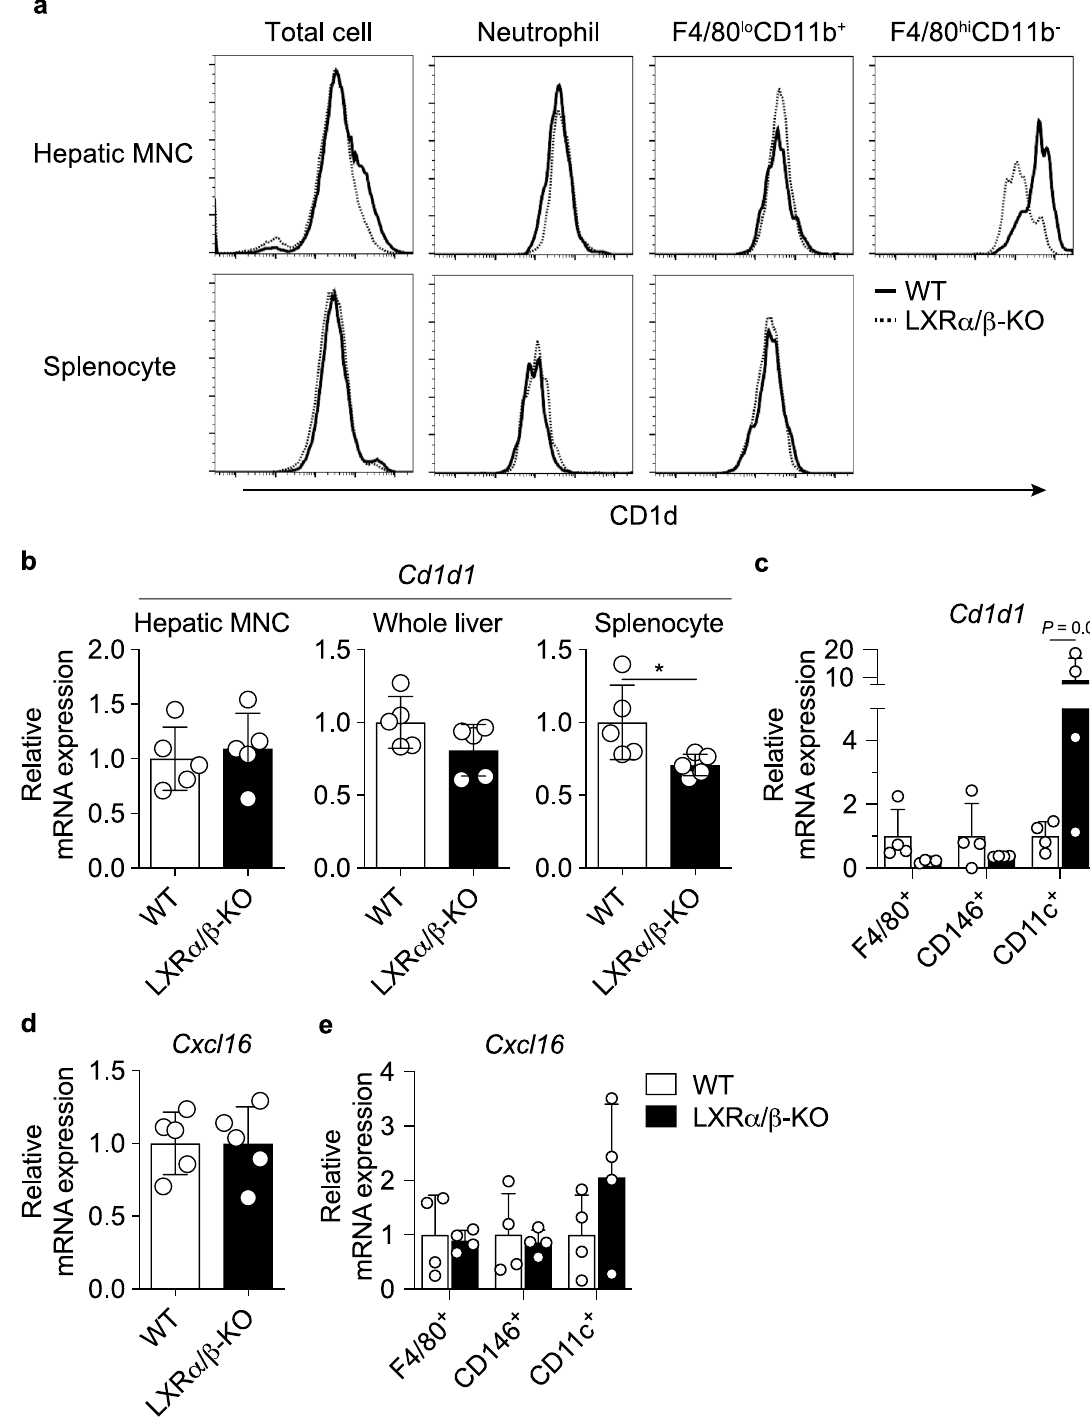
Figure 5. Expression of the MHC class I-like molecule CD1d and the chemokine CXCL16. ( a ) Representative flow cytometry for CD1d expression in hepatic immune cells and splenocytes. Hepatic MNCs and splenocytes were isolated from WT and LXRα/β-KO mice, and stained with APC-conjugated anti-CD1d antibody together with FITC-conjugated anti-F4/80 antibody and Pacific Blue- conjugated anti-CD11b antibody. Expression of CD1d was analyzed in hepatic MNCs, splenocytes, neutrophils (F4/80 − CD11b + ), BMDMs (F4/80 lo CD11b + ) and resident Kupffer cells (F4/80 hi CD11b − ). Similar results were obtained in repeated experiments (n = 4 for each analysis). ( b ) Cd1d1 mRNA expression in hepatic MNCs, whole liver samples and splenocytes. ( c ) Cd1d1 mRNA expression in F4/80 + Kupffer cells/macrophages, CD146 + liver sinusoidal endothelial cells and CD11c + dendritic cells isolated from hepatic MNCs. ( d ) Cxcl16 mRNA expression in hepatic MNCs. ( e ) Cxcl16 mRNA expression in F4/80 + Kupffer cells/macrophages, CD146 + liver sinusoidal endothelial cells and CD11c + dendritic cells isolated from hepatic MNCs. Hepatic MNCs with collagenase digestion, whole liver samples and splenocytes were obtained from WT and LXRα/β-KO mice (n = 5) ( a , b and d ). Hepatic MNCs were isolated after collagenase perfusion, and F4/80 + cells, CD146 + cells and CD11c + cells were sorted with magnetic beads. * P < 0.05 (Student’s t